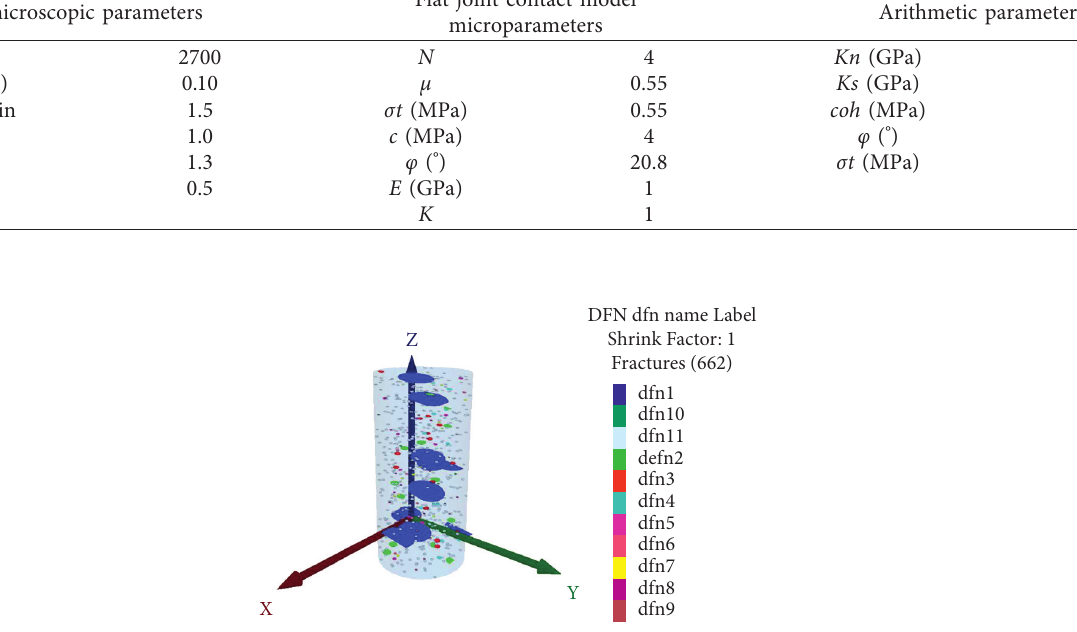
Figure 6: Coal sample 4 fracture structure. Table 3: Main characteristic parameters of the internal joints of the coal